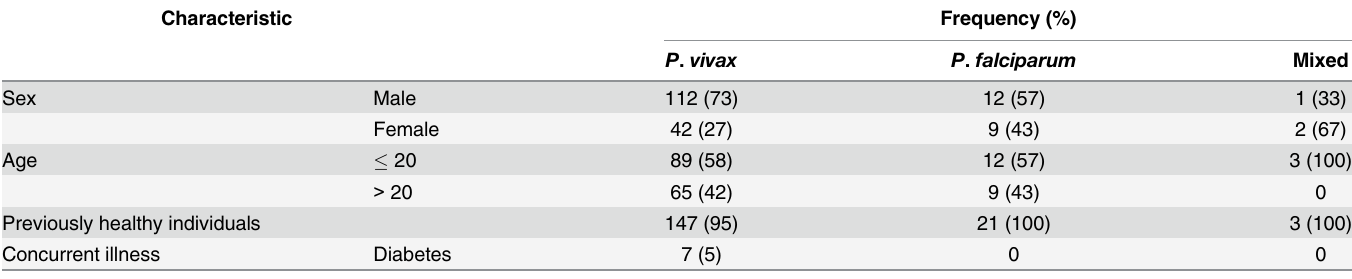
Table 1. Demographic characteristics of patients with P . vivax and P . falciparum infections, Orakzai Agency (FATA), Pakistan, 2011 – 2013 a .